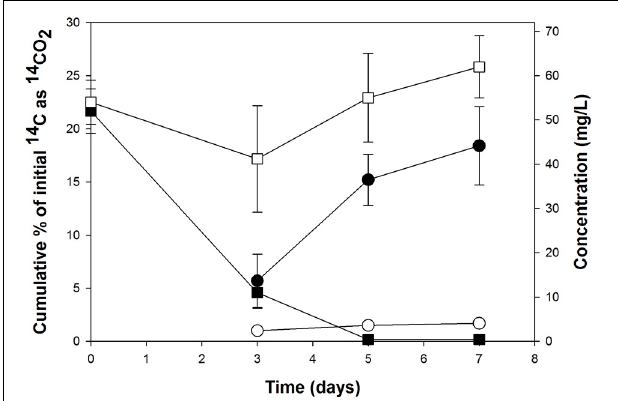
FIGURE 1 | Cumulative 14 CO 2 recovered from incubations with [ 14 C] n -hexadecane (circles) and disappearance of n -hexadecane as measured by GC-MS (squares) by the North Carolina surface seawater field sample. The endpoint for this SIP incubation was determined to be 7 days. Each data point is the mean ± standard deviation from triplicate incubations. Filled symbols represent live cultures (non-acid treated); open symbols represent acid-inhibited controls. Some error bars are smaller than the